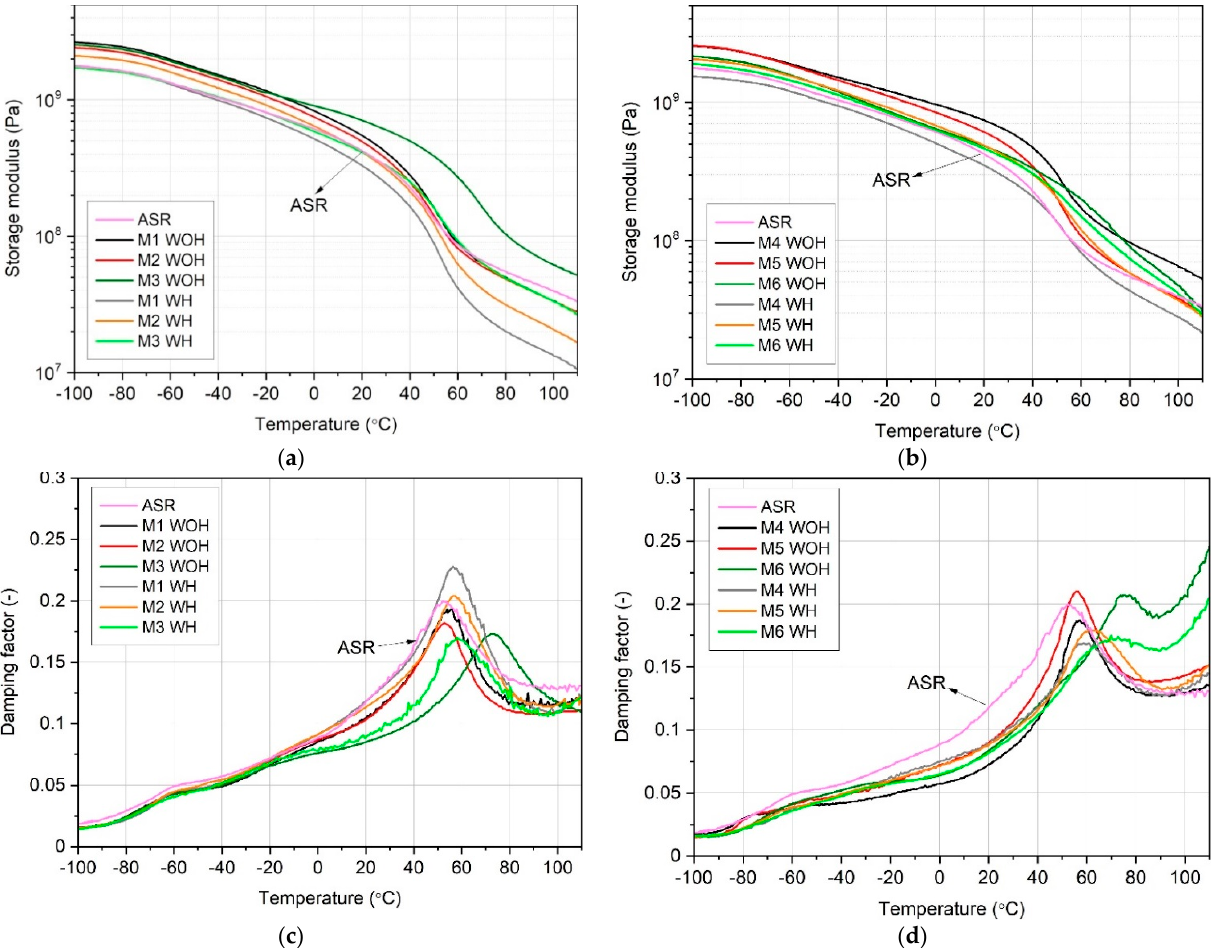
Figure 9. Plots of the storage modulus ( a , b ) and damping factor ( c , d ) of ASR-based compositions produced without homogenization (WHO) and with homogenization (WH).